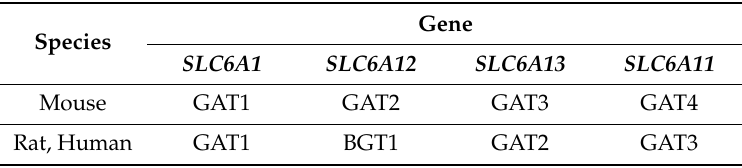
Table 1. Subtype names of GABA transporter (GAT) across